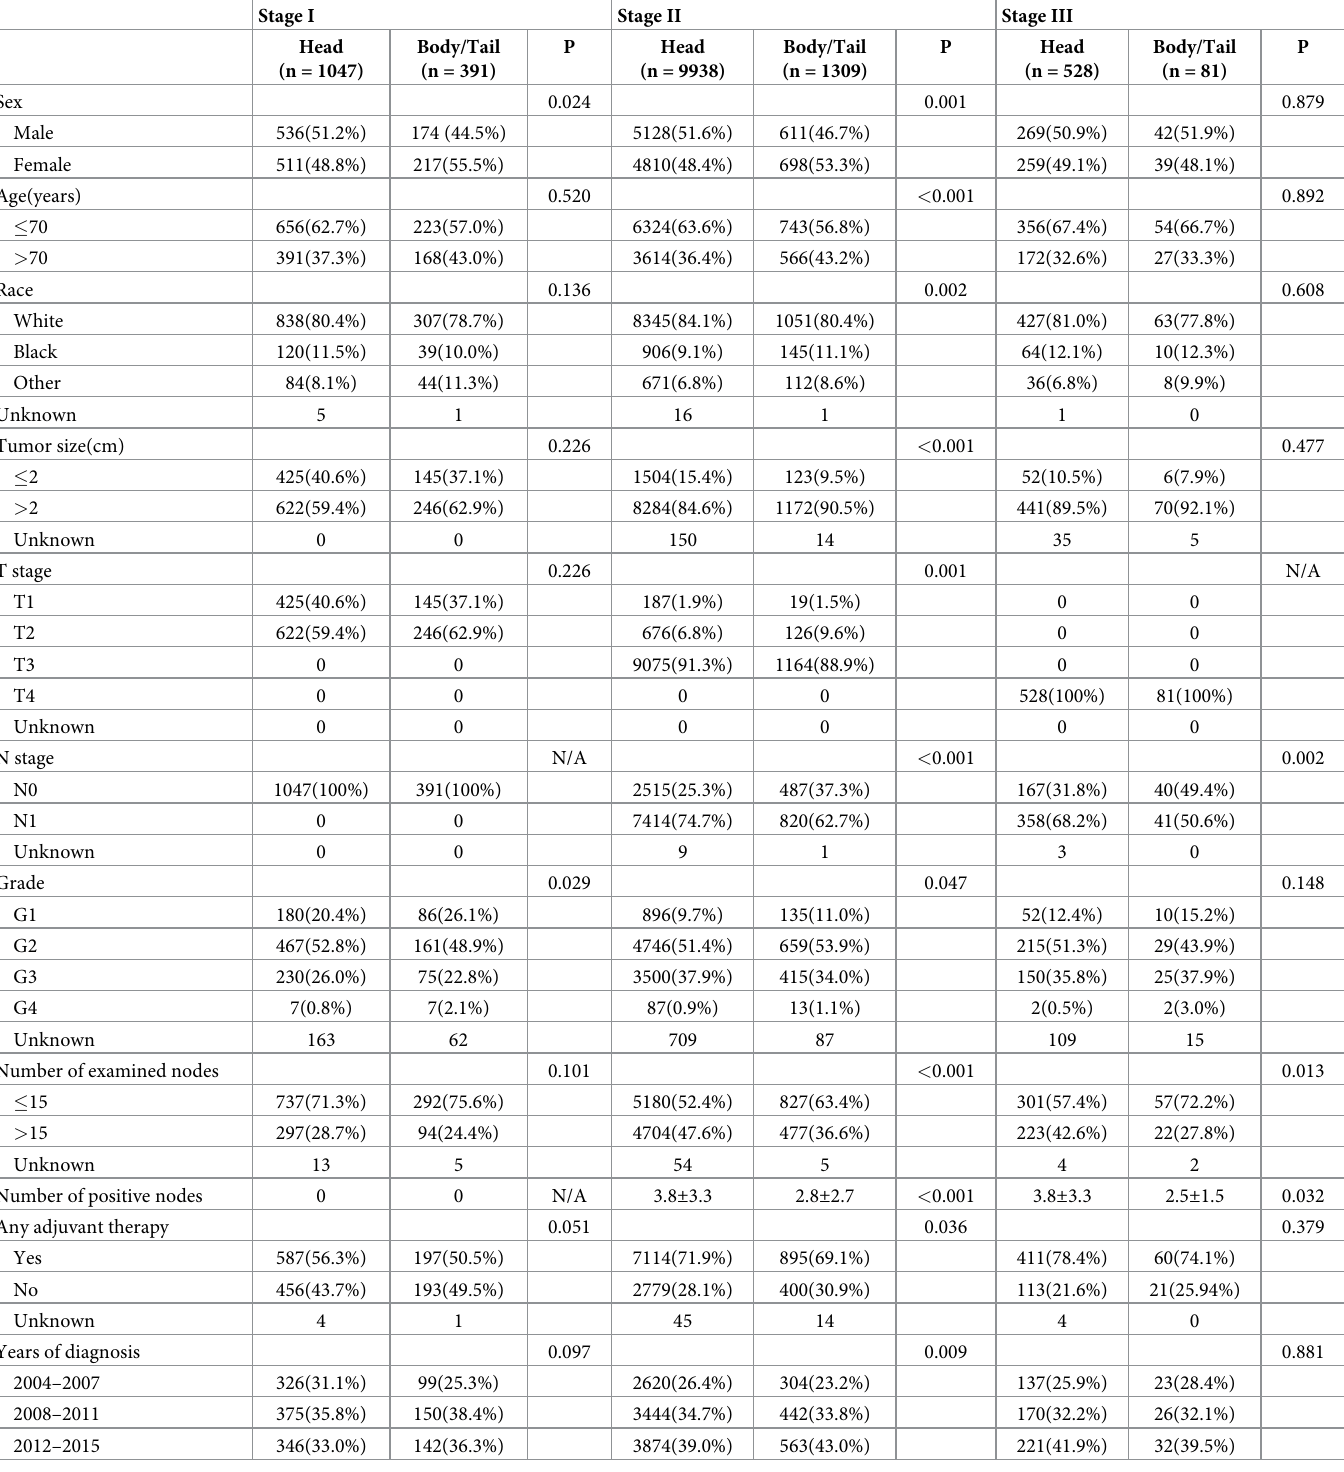
Table 3. Demographic and clinicopathological features of patients who underwent curative intent surgery for stage I to III pancreatic cancer by stage and